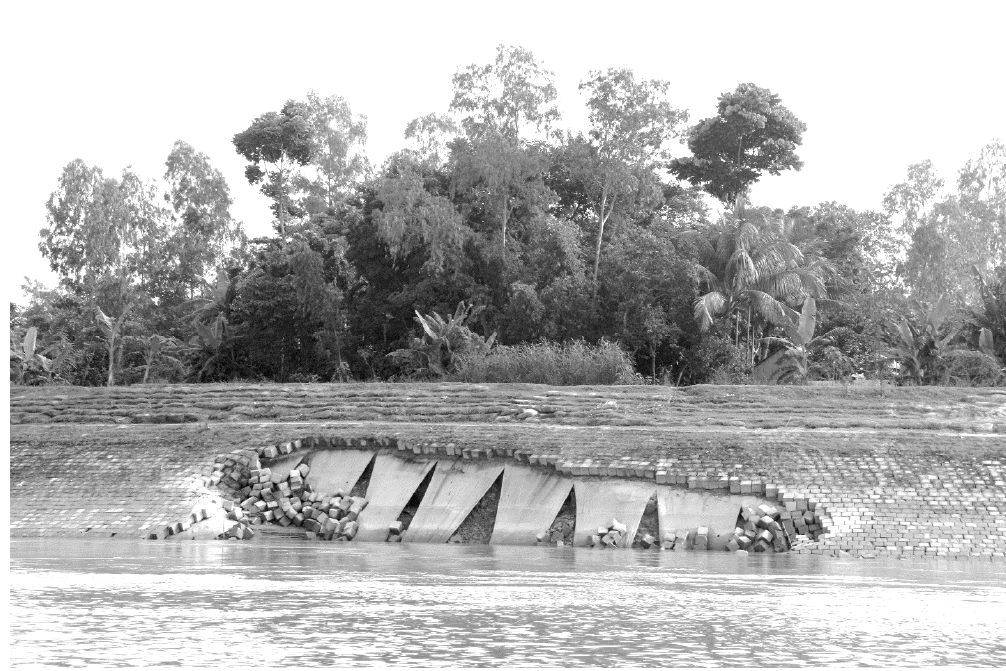
Figure 13. Typical revetment damage mostly occurring at the downstream half of a protected river bend, here seen at Bahadurabad near Jamalpur in November 2019, (photo